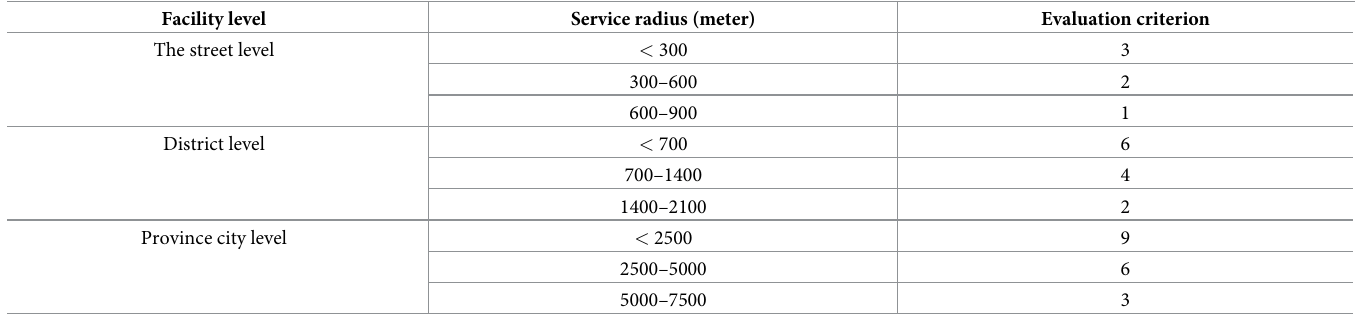
Table 3. Service radius and evaluation standard of public sports facilities at all